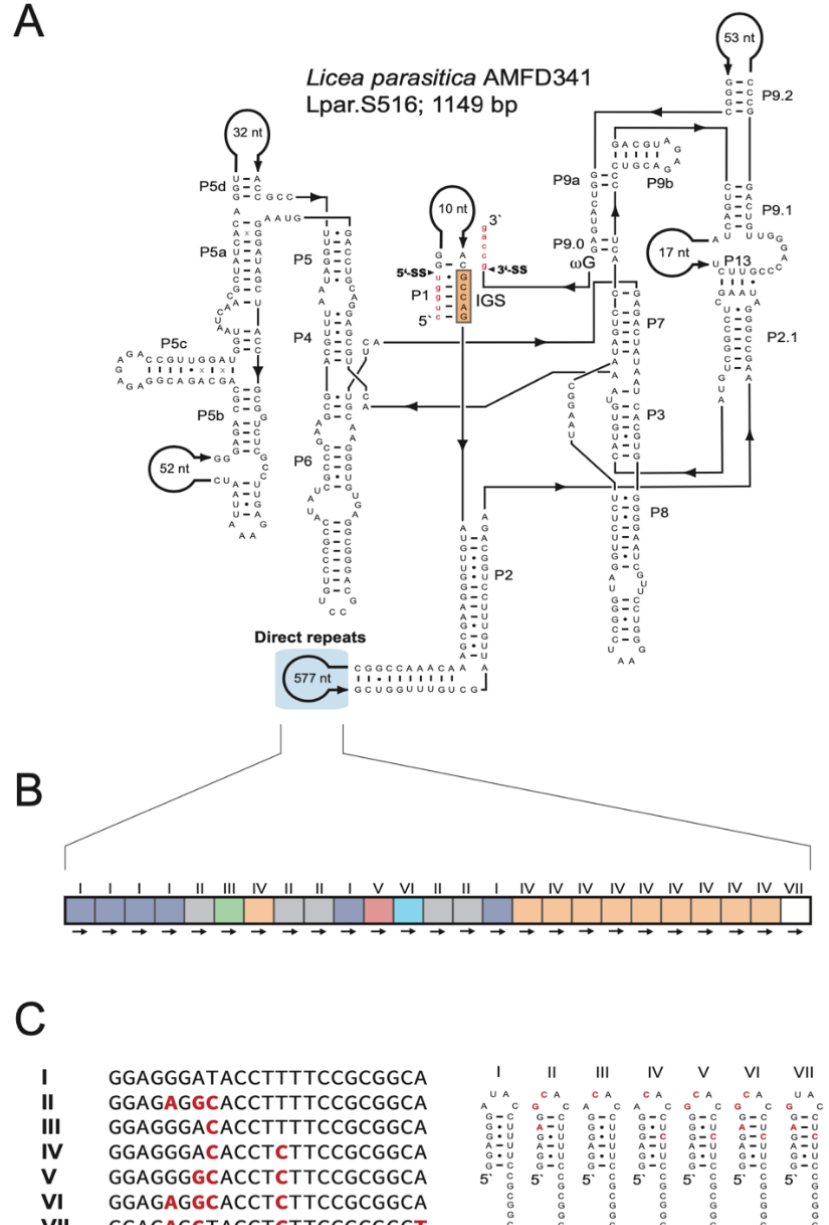
Figure 5. Direct repeat arrays in peripheral regions. ( A ) Secondary structural diagram of the S516 group I intron RNA in Licea parasitica containing direct repeats in the P2 peripheral region. For structural annotations, see legend to Figure 1. ( B ) Schematic organization of the direct repeats, which consists of 25 copies and seven motif variants (I to VII). ( C ) Alignment of sequence variants (left) and possible RNA hairpin structure formation (right).